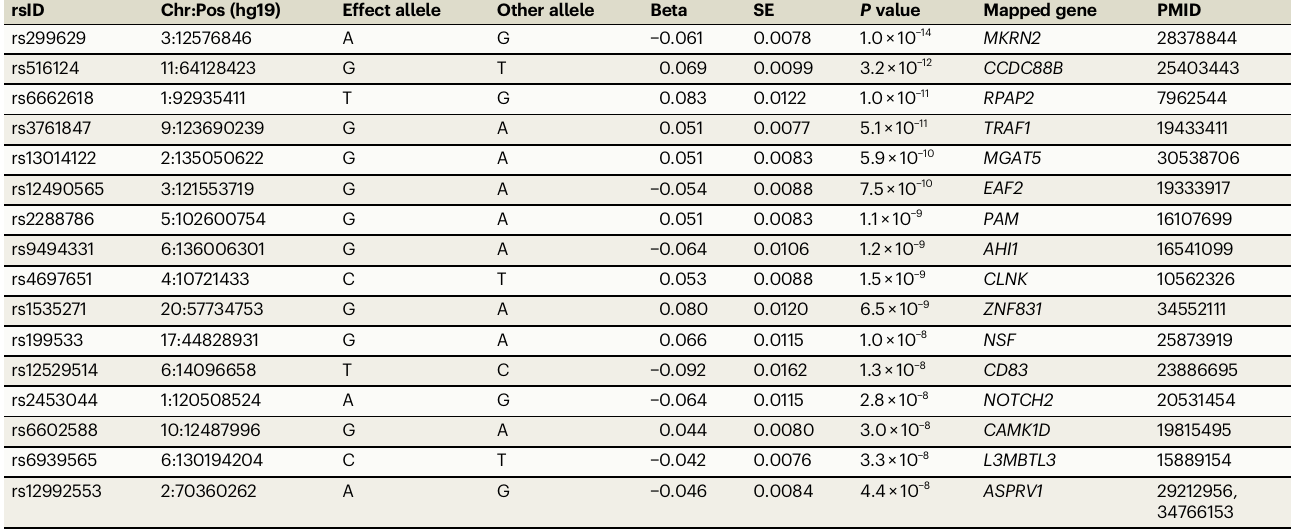
Table 1 | List of sentinel variants at sixteen replicable novel loci from the multi-ancestry and multi-trait